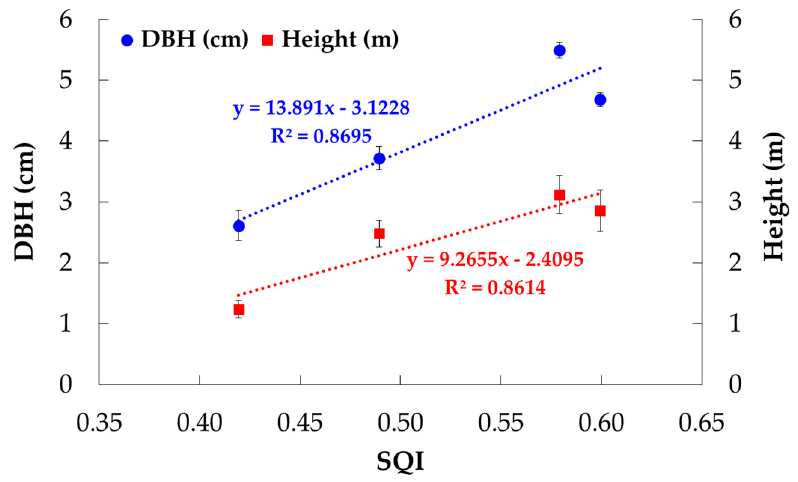
Figure 6. Correlation between SQI and plant growth attributes: DBH and plant height, of di ff erent ages (2014–2017).